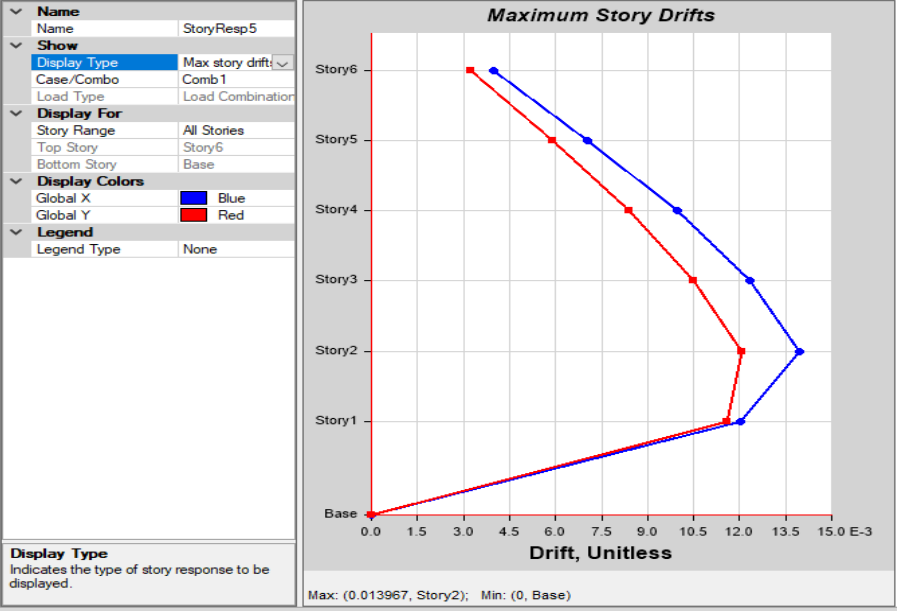
Figure 15. Maximum story drifts.